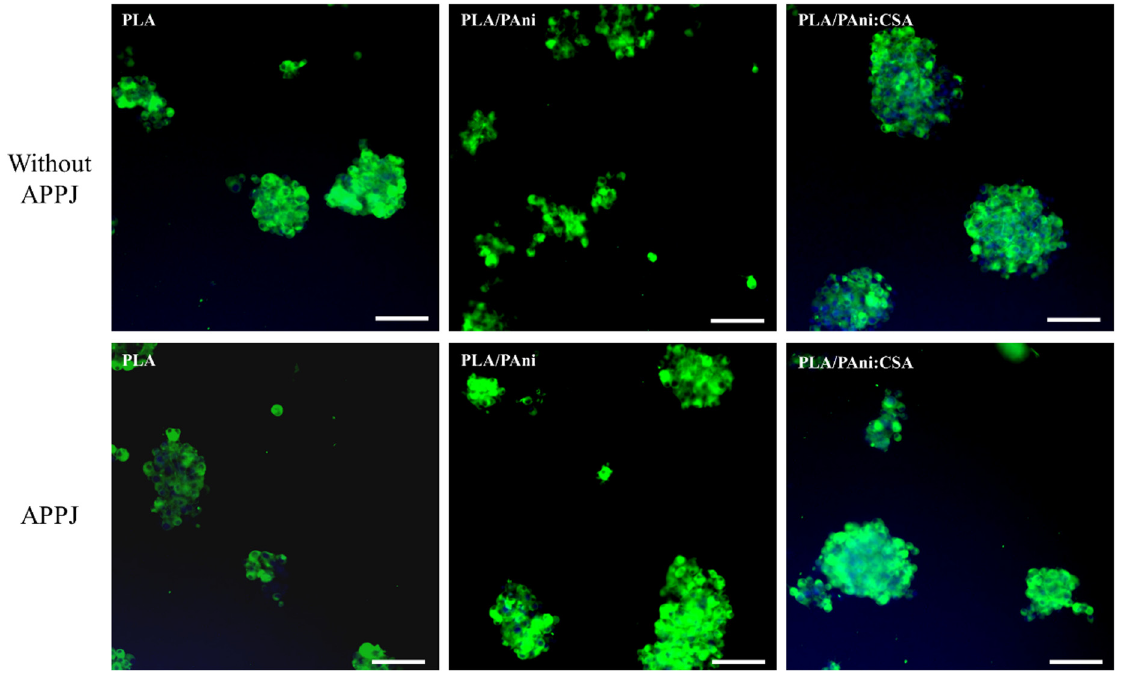
Figure 9. Representative immunofluorescent images of PC-12 cells cultured on untreated and APPJ- treated PLA, PLA/PAni and PLA/PAni:CSA nanofibers for 10 days (Scale bar: 100 μ m).